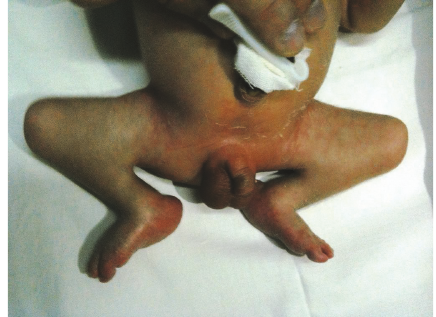
Figure 1: The “frog-like” appearance of the infant due to popliteal pterygium.